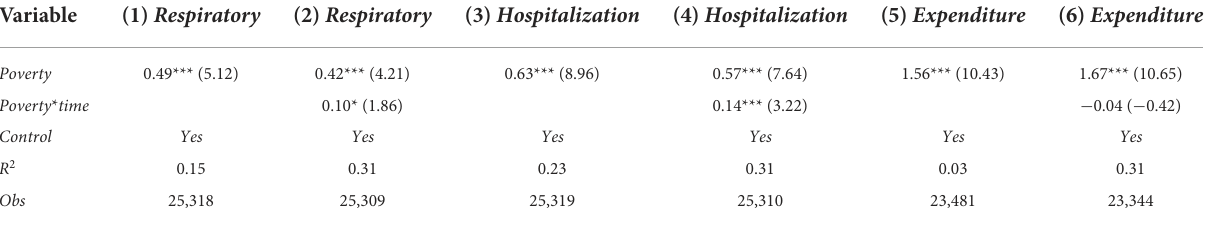
TABLE 4 Moderating effect